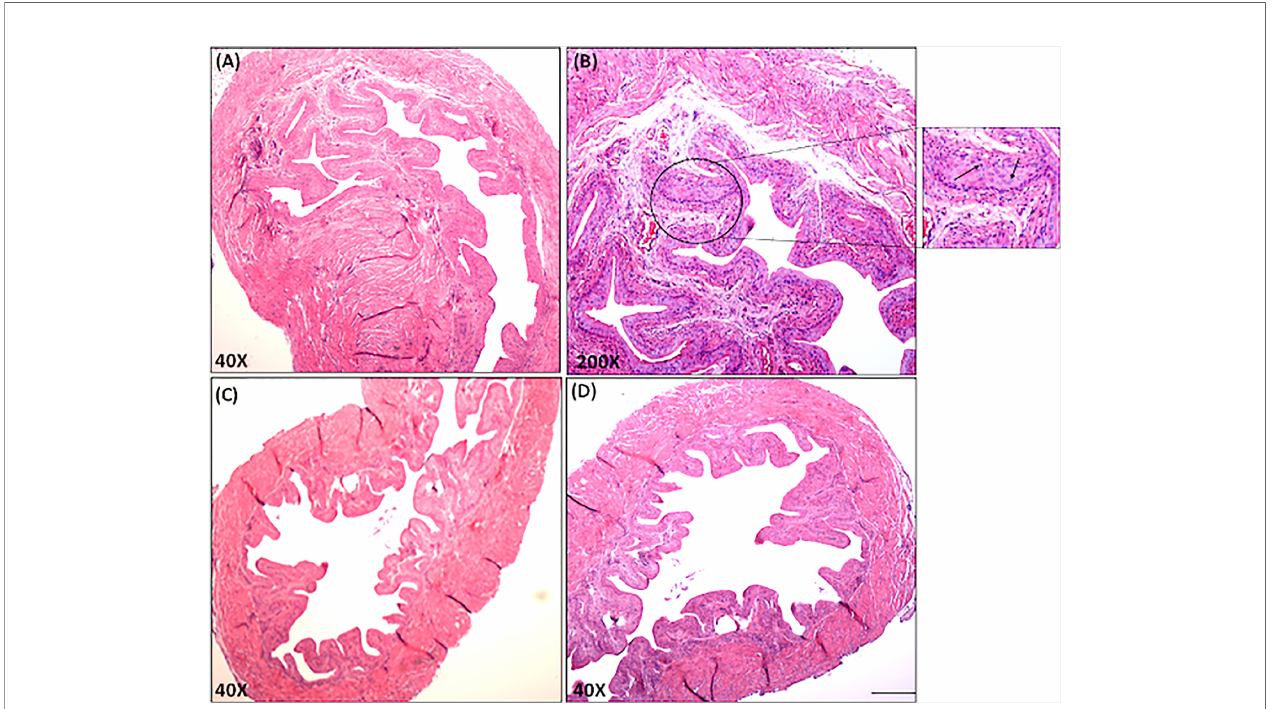
FIGURE 6 | Histopathological changes in the urinary bladder of chronic IC development. Urinary bladder histopathological sections from control and IC are shown at different magni fi cations ( A, C, D X40; B , X200). Upper Panels A and B shows sections from IC-induced mice illustrate in fl amed bladders characterized by differences in mucosal wall thickness, narrow bladder space, enlargement of the mucosal layer and leukocyte in fi ltration (arrows in the inset). These histological features of IC model share similarities with clinical IC pathology. Panel C and D shows normal bladder space, no cellular in fi ltrates, and normal epithelial cells. Representative pictures are from 3 independent experiments using 6 mice in each group. Bar 200 m m (A – D) .